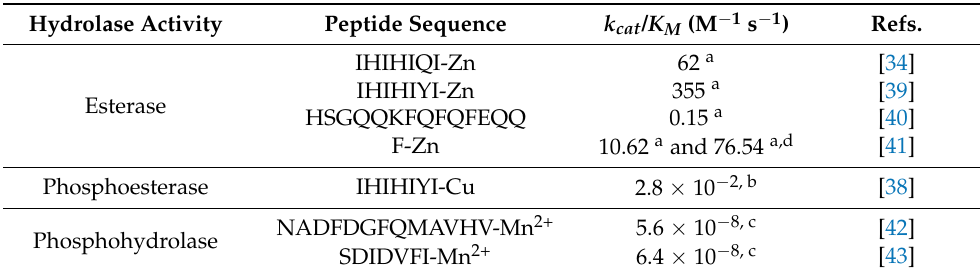
Table 1. Hydrolase activities of different types of catalytic